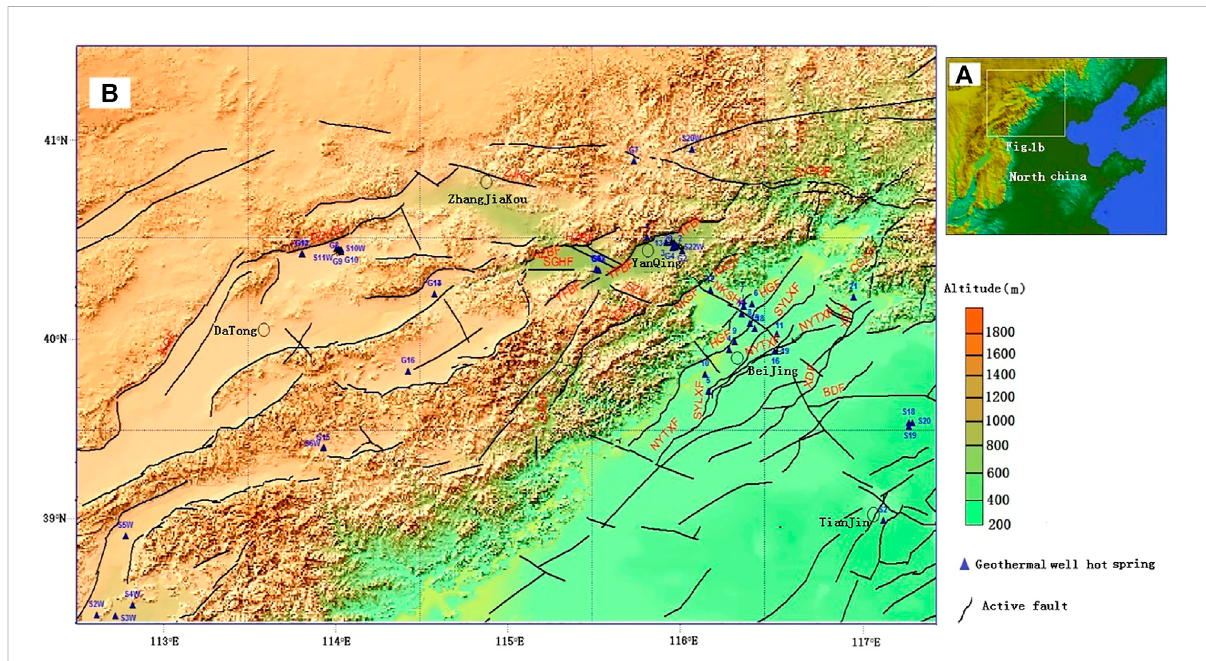
FIGURE 1 Distribution ofgassamplingsitesofhot springs ingeothermalwellsof theZhangjiakou-Bohai FaultZone. (A) Topographic mapofNorthChina. (B) Topographic map of the Zhangjiakou-Bohai Fault Zone and location map of sampling sites, active faults according to Xu et al.